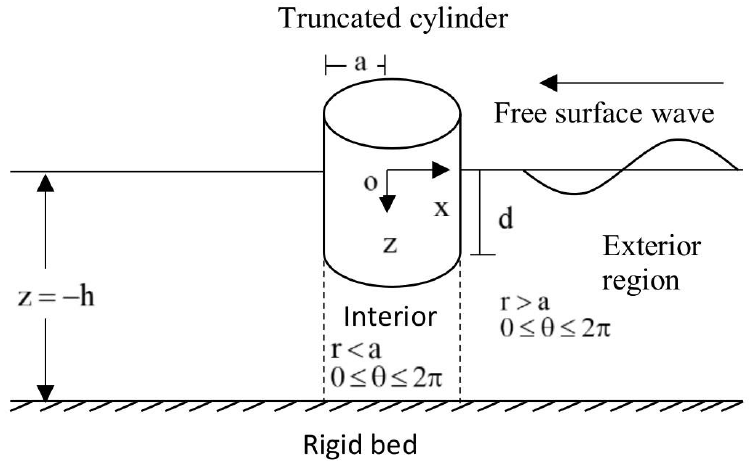
Figure 1. Schematic diagram of wave diffraction by a floating fixed truncated vertical cylinder.